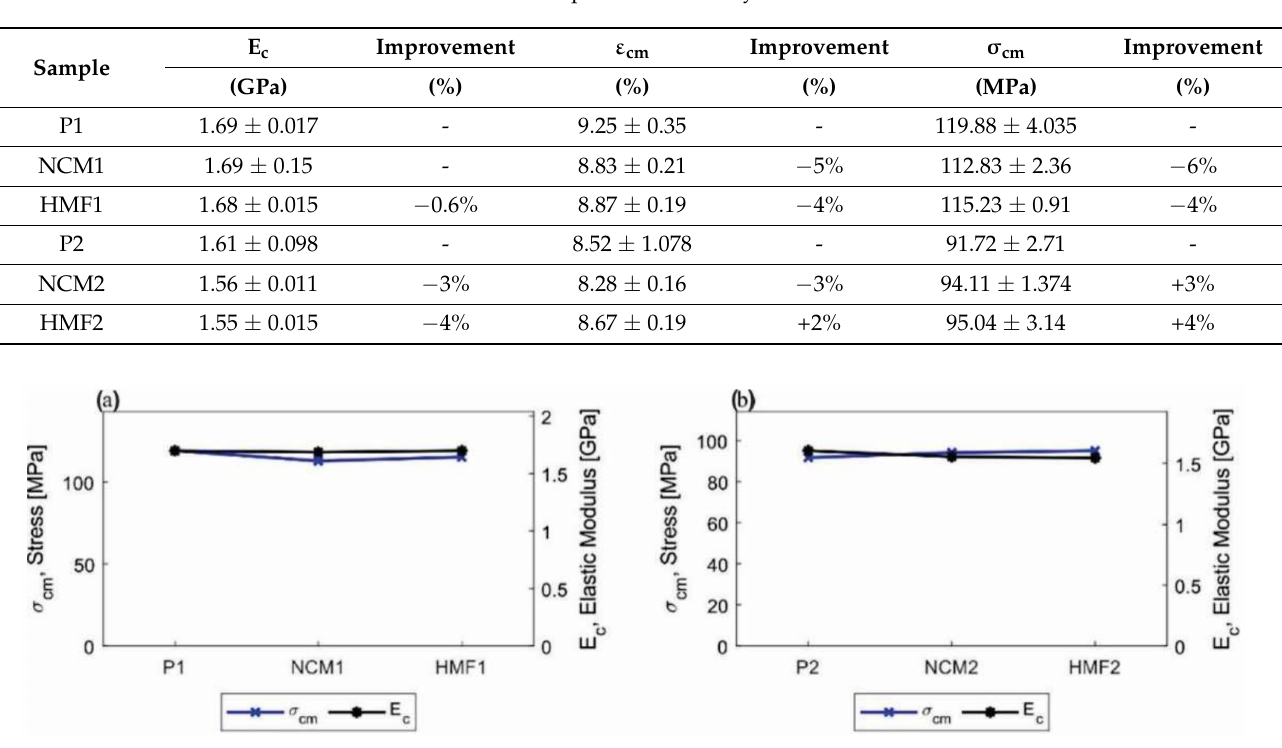
Table 4. Results of the compression test analysis.